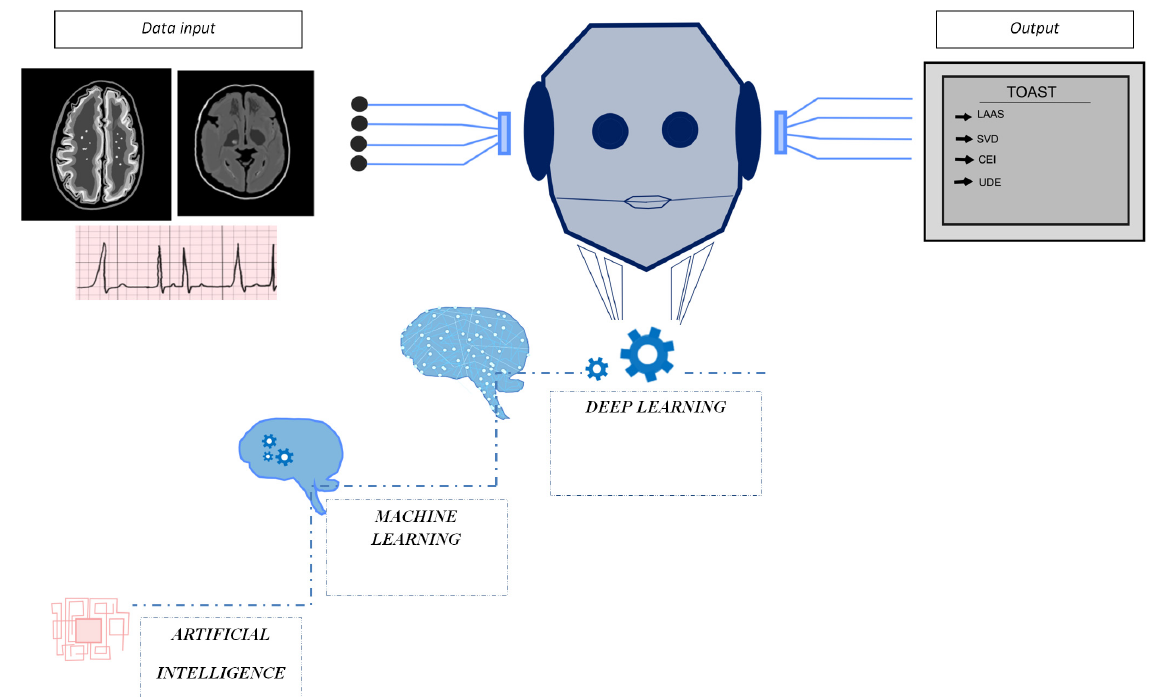
Figure 1. Artificial intelligence in stroke diagnosis according to TOAST classification. Artificial intelligence path over recent years has been a stairway to matching human complexity, introducing increasingly complex networks of data processing, among which deep learning is nowadays one of the leading figures. These complex algorithms allow for elaborate input data (e.g., MRI, ECG leads), which are acquired, read, and finally processed and interpreted. The possibility to elaborate data from ECG, MRI, CT images, and ultrasound allow for an elaborate algorithm for stroke subtype diagnosis.